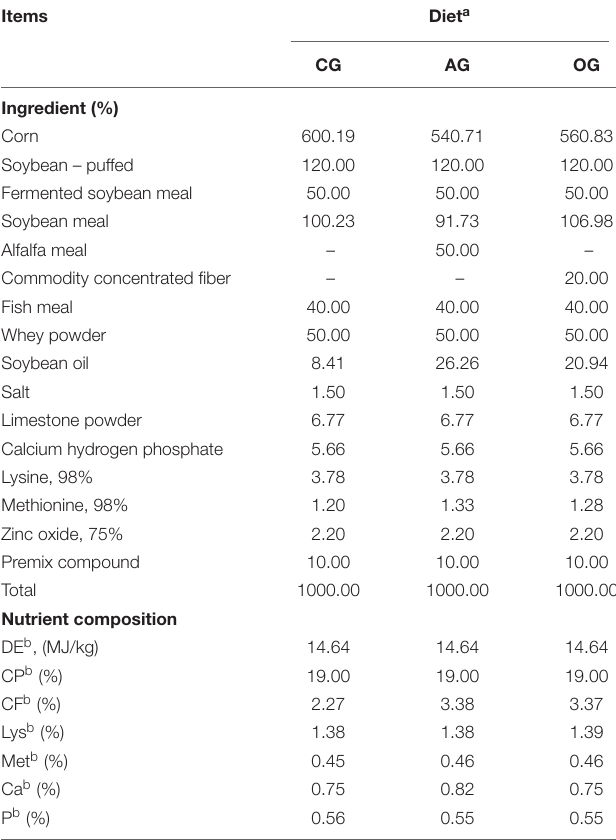
TABLE 1 | Ingredient and nutrient composition (%, as feed) of the experimental